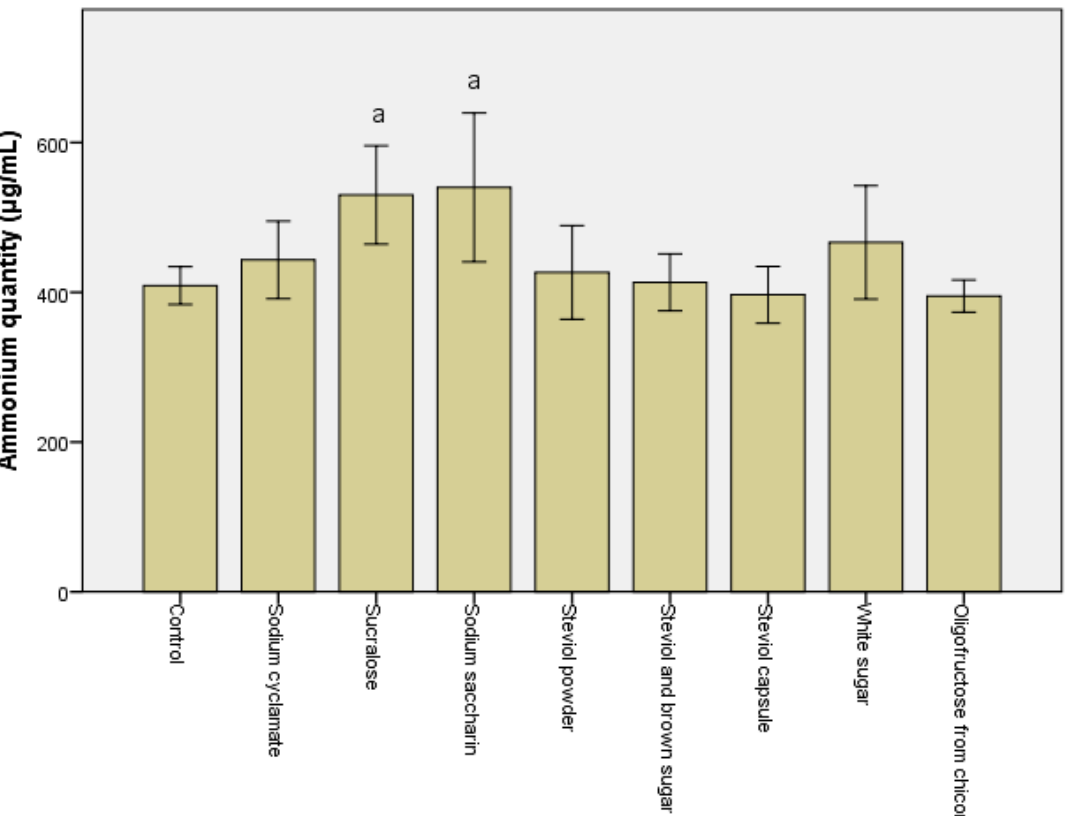
Table 3. Organic acid levels ( μ g/mL) obtained after the in vitro tests through GIS1 as a measure of the impact of the sweeteners consumed on the metabolic activity of the microbiota.